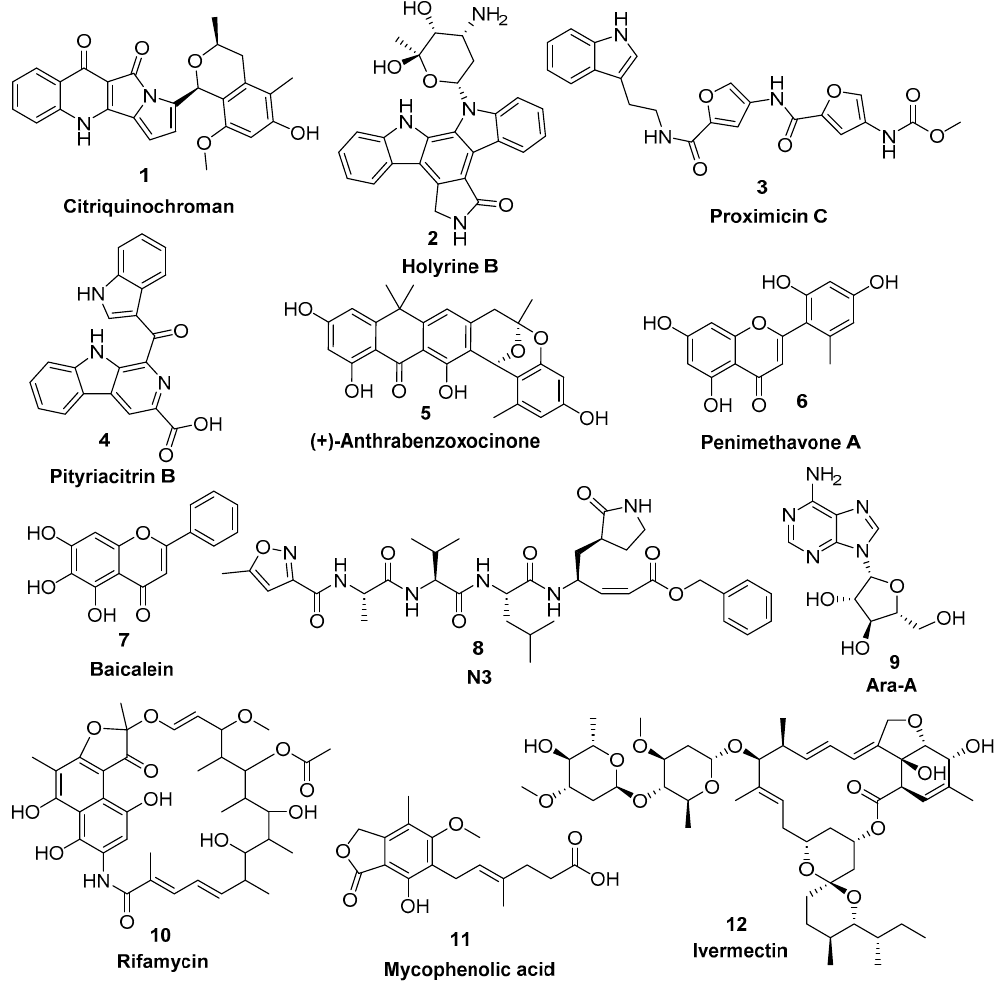
Figure 4. Top-scoring compounds ( 1–6 ) retrieved from the in silico virtual screening on the M pro active site along with the co-crystallized inhibitors 7 and 8 in addition to the previously reported antiviral microbial natural products ( 9–12 ).